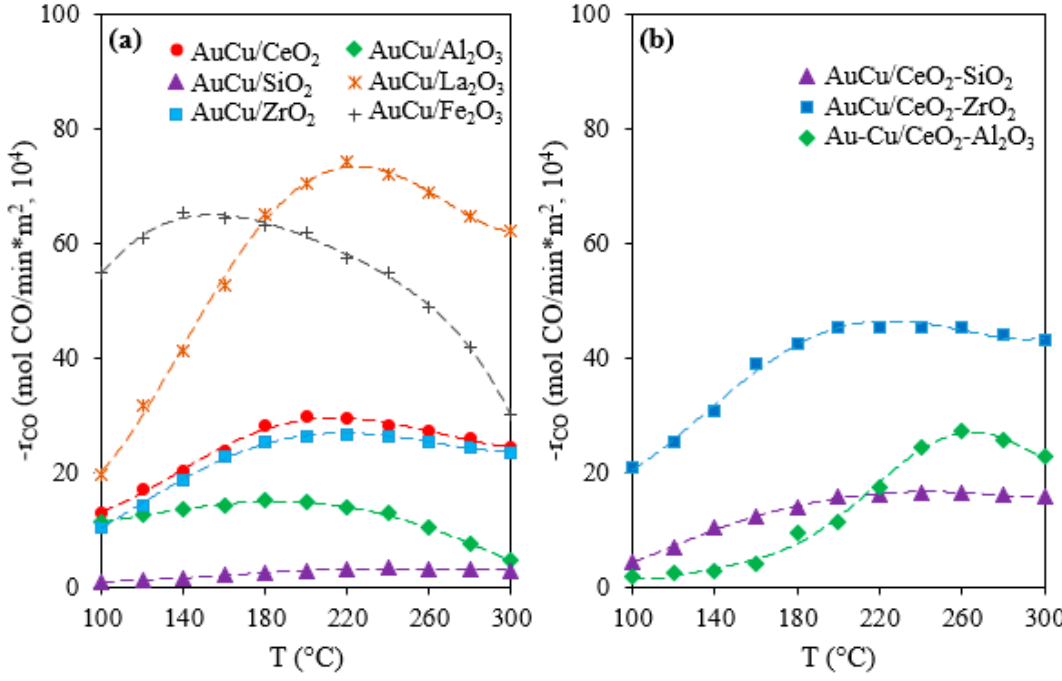
Figure 7. CO conversion rate normalized by the surface area of the Au–Cu catalysts supported in ( a ) single and ( b ) dual metal oxides.